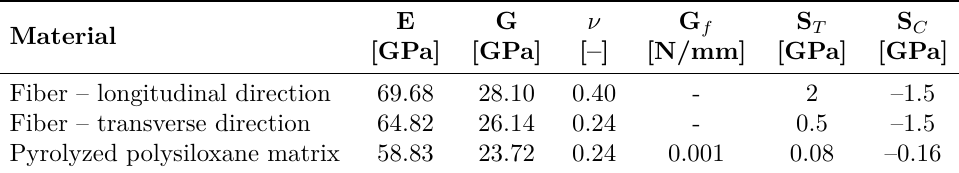
Table 2. Considered parameters of individual